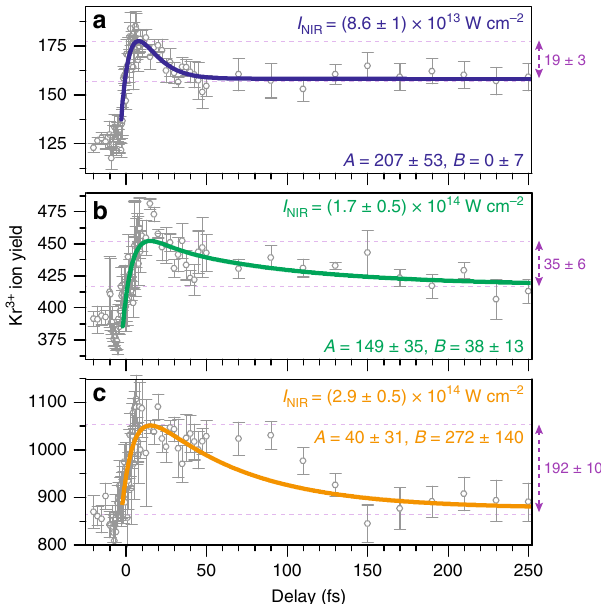
Fig. 4 Control of Kr ionization dynamics. Time-dependent Kr 3+ ion yield for three different NIR intensities: a I NIR = (8.6 ± 1) × 10 13 W cm − 2 , b I NIR = (1.7 ± 0.5) × 10 14 W cm − 2 and c I = (2.9 ± 0.5) × 10 14 W cm − 2 . While for all NIR three intensities, the rise in the Kr 3+ ion yield obeys the 7.9 fs 3 d − 1 np lifetime, the subsequent decrease of the ion counts is strongly affected by the NIR intensity: a double exponential least squares fi t yields the decay constants of τ A = 9.3 ± 3.7 fs and τ B = 60 ± 26 fs with varying contributions in their amplitudes for the three intensities: a A = 207 ± 53, B = 0 ± 7, b A = 149 ± 35, B = 38 ± 13 and c A = 40 ± 31, B = 272 ± 140. This